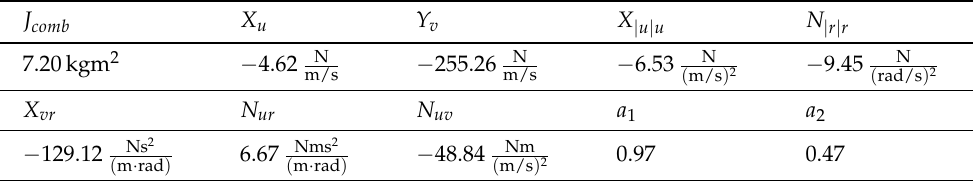
Table 2. Estimated parameters (reduced parameter